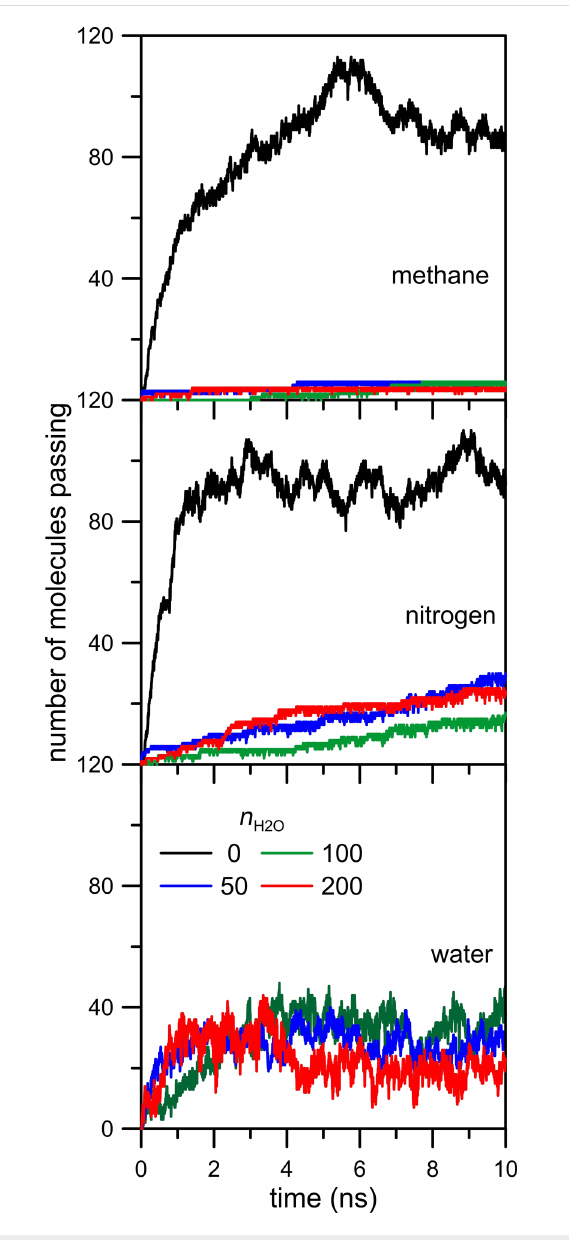
Figure 13: The influence of the number of water molecules present in the gaseous mixture on the number of CH 4 and N 2 molecules passing through an NN nanopore at 300